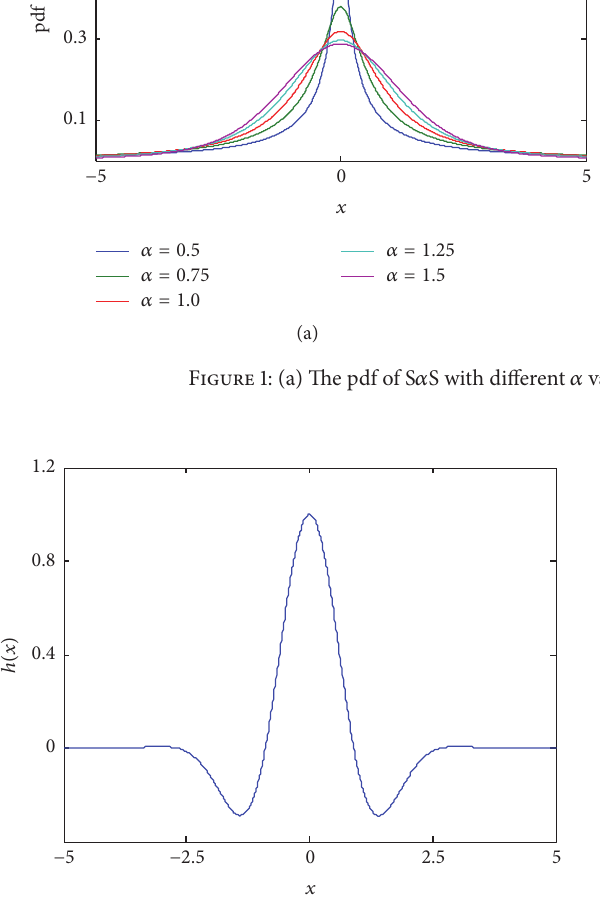
Figure 2: The Morlet wavelet